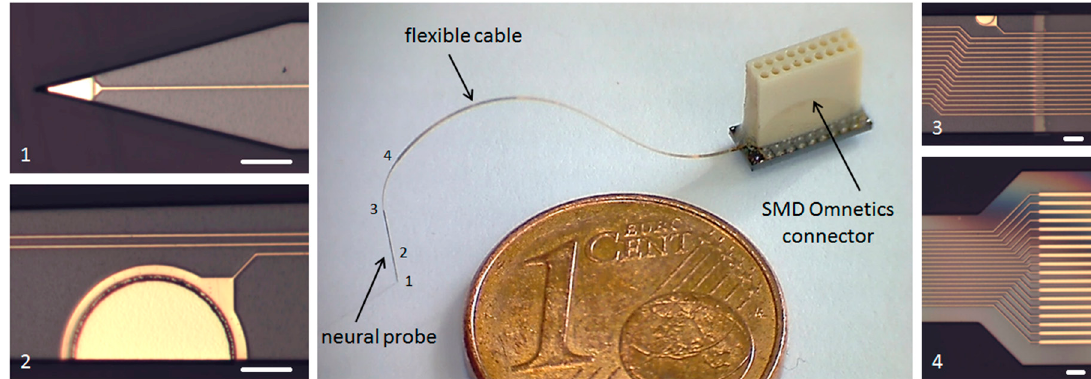
Figure 7. Microfabricated silicon-stiffened neural probe (5 mm long, 30 µ m thick and max. 130 µ m wide) with monolithically integrated 25 mm long flexible cable (10 µ m thick PI) connected to a soldered and encapsulated 0.64 mm pitch 18-pin SMD Omnetics connector with enlarged top view of ( 1 ) probe tip with a 160 µ m 2 microelectrode (scale bar 30 µ m); ( 2 ) probe shaft with a 3000 µ m 2 microelectrode (scale bar 30 µ m); ( 3 ) transition of the probe shaft with a 160 µ m 2 microelectrode to the flexible ribbon cable (scale bar 20 µ m); ( 4 ) widening of the gold conductive paths 3 mm after the probe/cable transition from 5 µ m to 10 µ m pitch (cable width increases from 130 µ m to 230 µ m, scale bar 15 µ